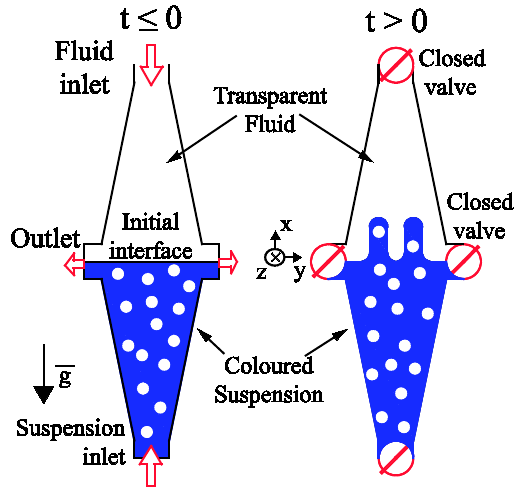
Figure 1. Scheme of the experimental setup. The auxiliary flow system (left, t < 0) makes it possible to obtain a sharp interface as initial condition between the coloured suspension and the transparent fluid. Once the system is stopped and the valves closed (right), the less dense particles rise carrying the solute across the initial interface.